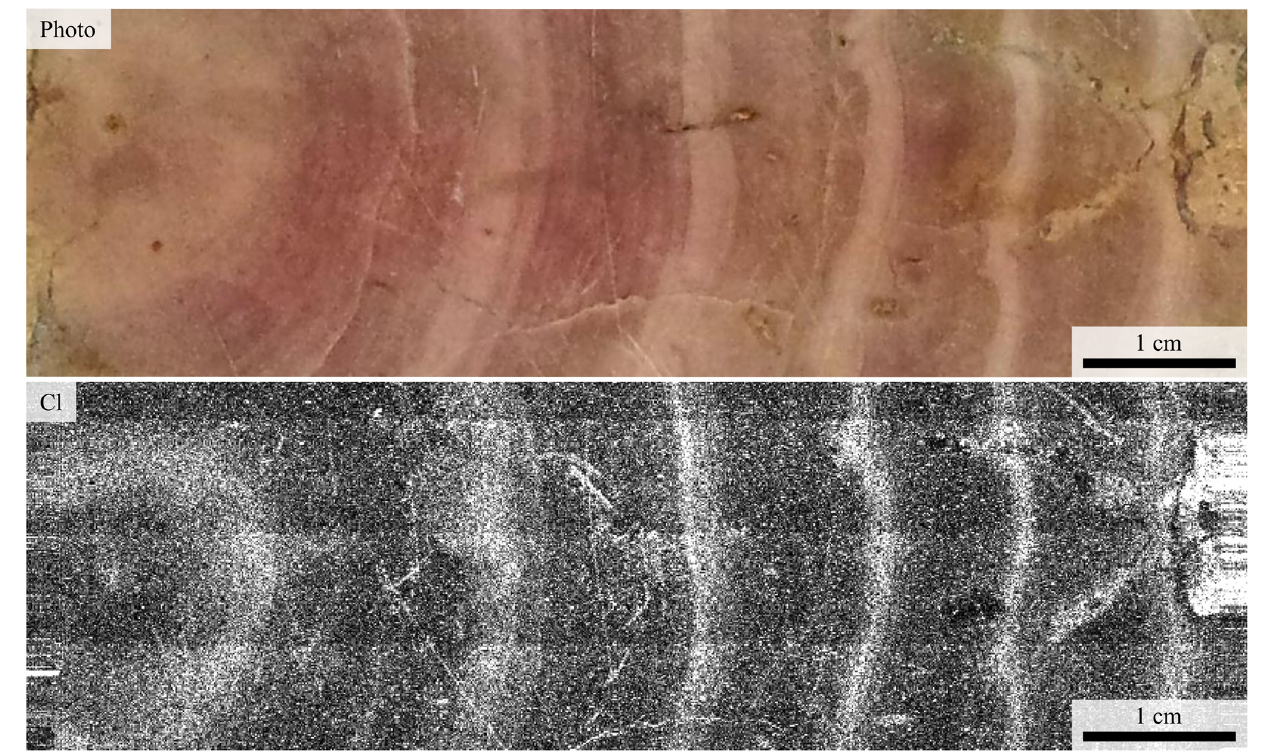
Fig 8. XRF map of Cl in UOM-232 with corresponding photograph in longitudinal section. Cl is clearly enriched in the white bands. White represents high abundances and black represents low abundances.